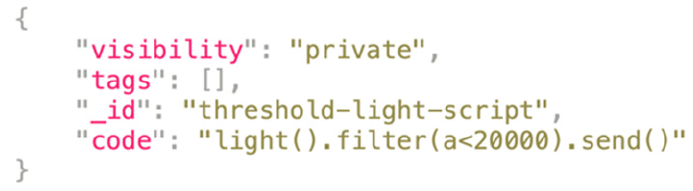
Figure 4. A sample script JSON description. Table 4. Operations currently available in the Edgine script language.